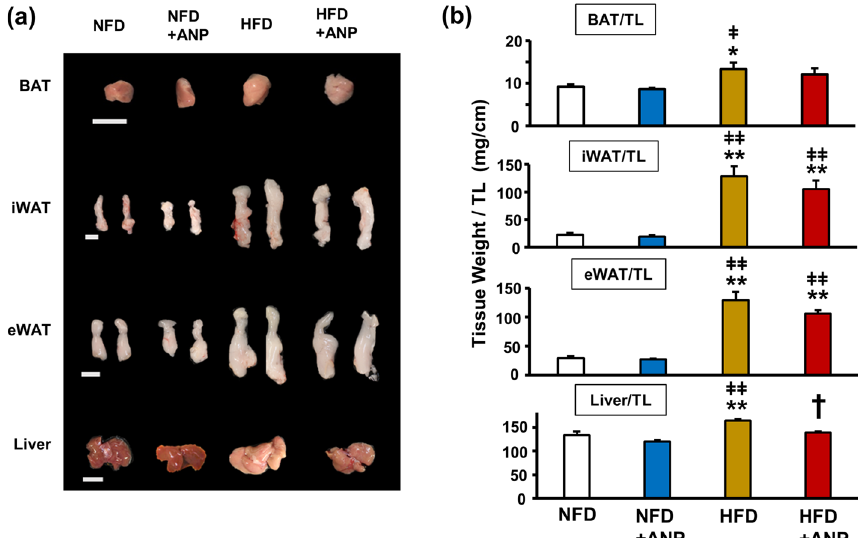
Figure 2. Macroscopic appearances and weights of the adipose tissues and the liver. The representative images ( a ) and weight ( b ) of each tissue harvested from the indicated mice at three weeks after treatment with or without ANP (n = 6 each). Bars = 1 cm. Data are mean ± SEM. * P < 0.05 and ** P < 0.01 versus NFD; † P < 0.05 versus HFD; ǂ P < 0.05 and ǂǂ P < 0.01 versus NFD + ANP. BAT, brown adipose tissue; iWAT, inguinal white adipose tissue; eWAT, epididymal white adipose